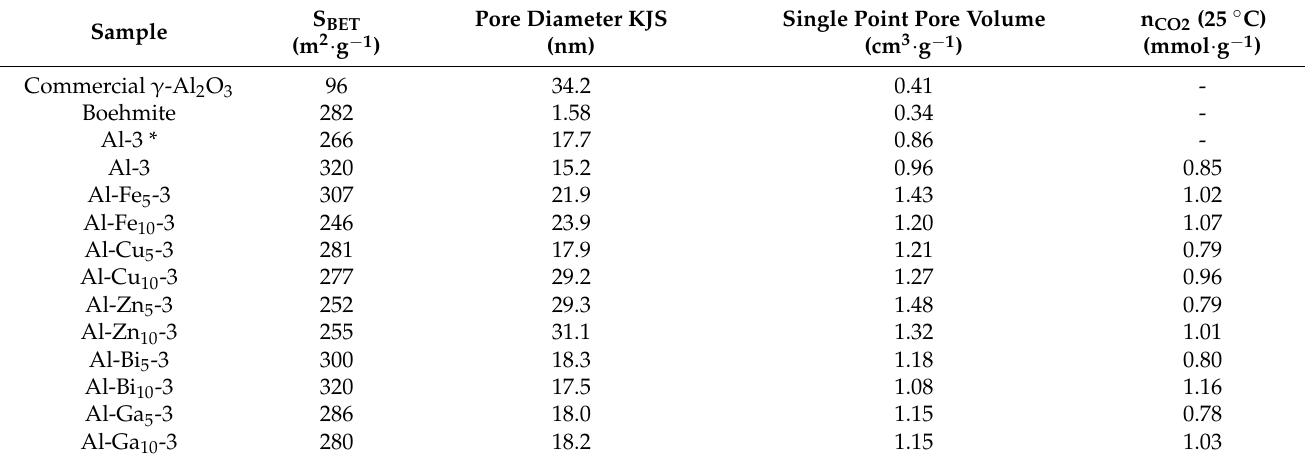
Table 2. Textural properties of the synthesized samples.